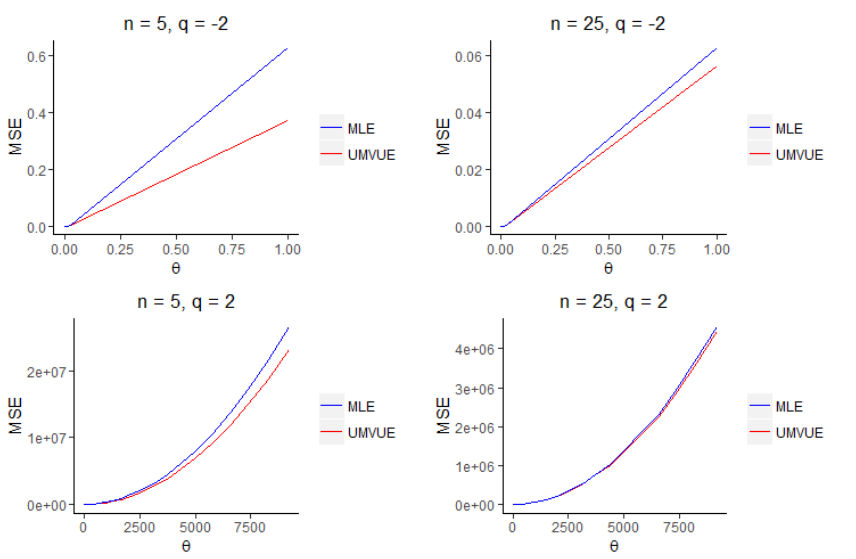
Figure 1 – MSE of the UMVUE and MLE of θ q for different sample sizes and values of q .